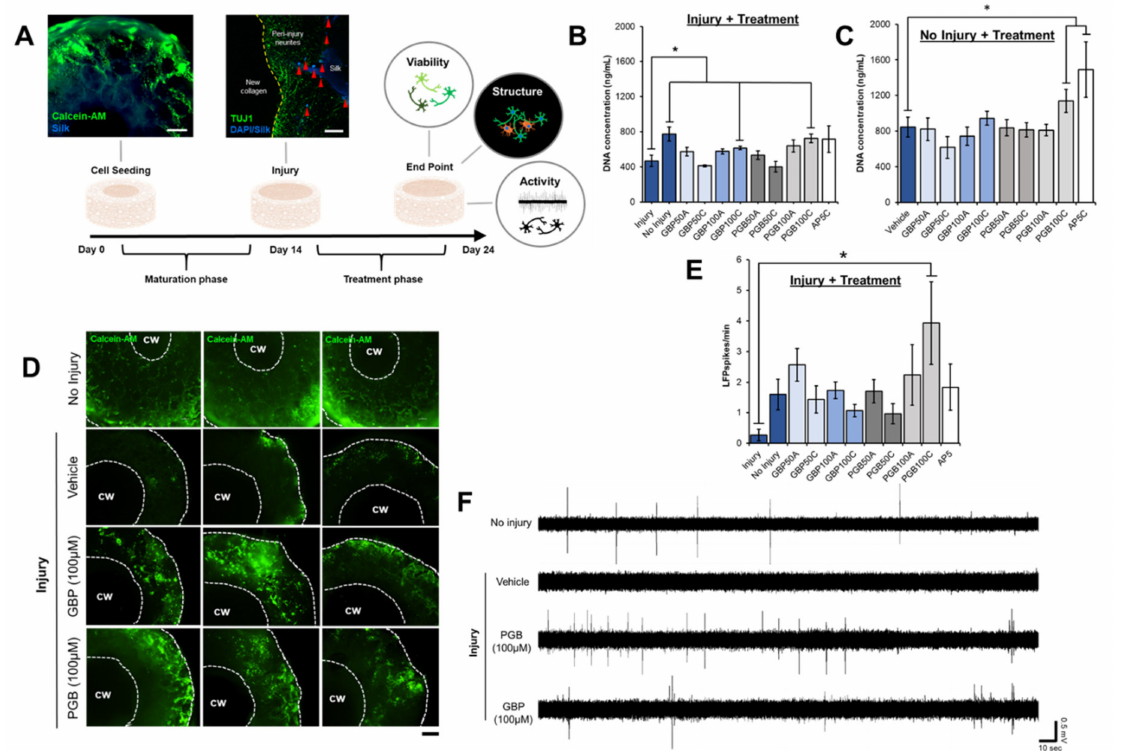
Figure 3. Treatments e ff ects upon injured and non-injured 3D neural tissues. ( A ) Cells were seeded on Day 0 and matured for 14 days, injured, and received treatment for up to 10 days post-laceration after which they were assessed. ( B ) DNA concentration in injured and ( C ) non-injured samples associated with acute and chronic exposures of GBP (50 µ M or 100 µ M), PGB (50 µ M or 100 µ M), and AP5 (100 µ M) assessed 10 days post-injury are displayed. Acute and chronic treatments are indicated by A and C, respectively. ( D ) Live imaging confirmed the presence of increased live cell populations in injured samples exposed chronically to high concentrations (100 µ M) of GBP and PGB relative to those treated with the vehicle. White dotted lines encircle the outer perimeter of the sample as well as the inner perimeter of the central window (cw). The scale bar represents 500 µ m. ( E ) Local field potentials (LFPs) recorded from the injured samples ( n = 9 / group) 10 days post-injury revealed a marked reduction in electrical activity (LFP spikes / min) relative to the non-injured controls, a phenomenon which was reversed by a chronic administration of 100 µ M PGB ( p < 0.05). ( F ) Representative traces for the main conditions are provided with scales (20 s, 0.5 mV). Means ± SEMs and the significant di ff erences between groups are indicated (* p <